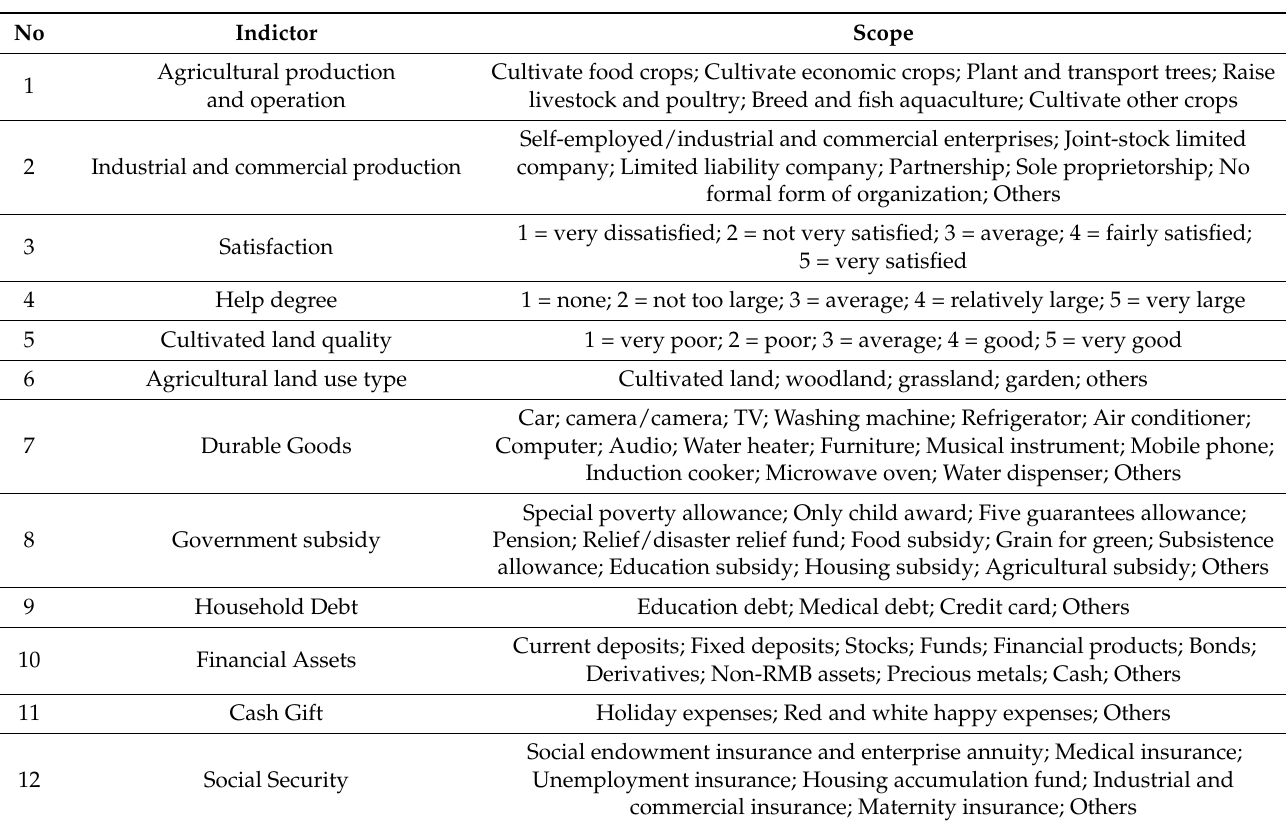
Table A1. Scope of the explanatory